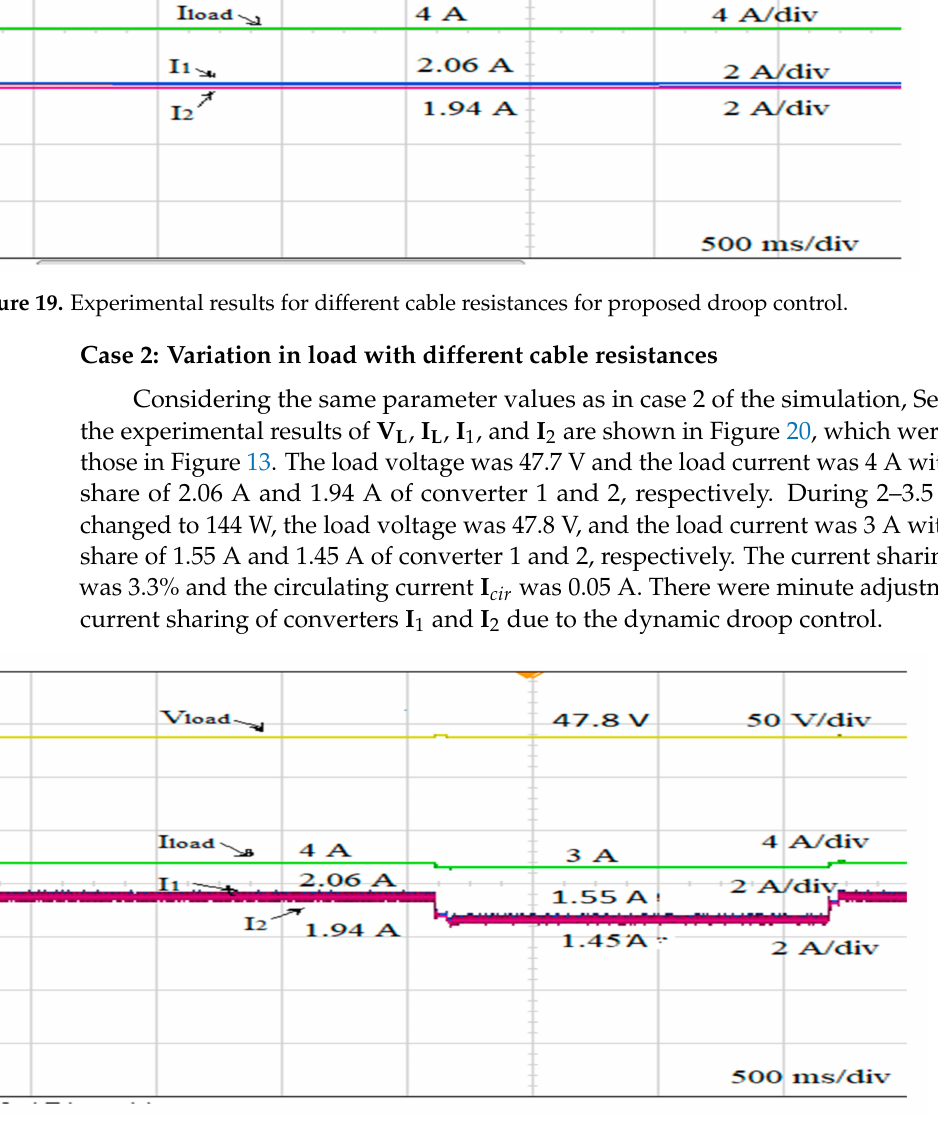
Figure 20. Experimental results for variation in load with different cable resistances for proposed droop